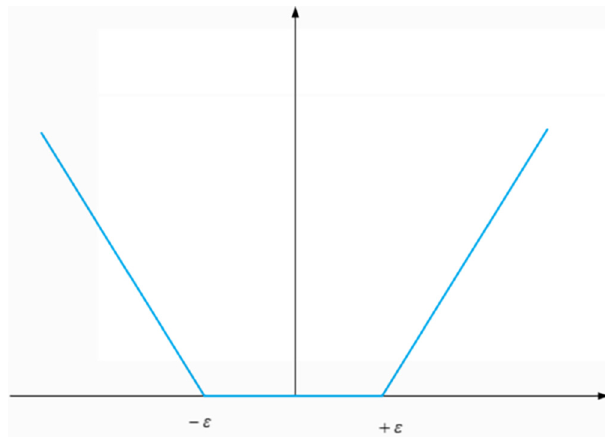
Fig. A.1. The e -insensitive